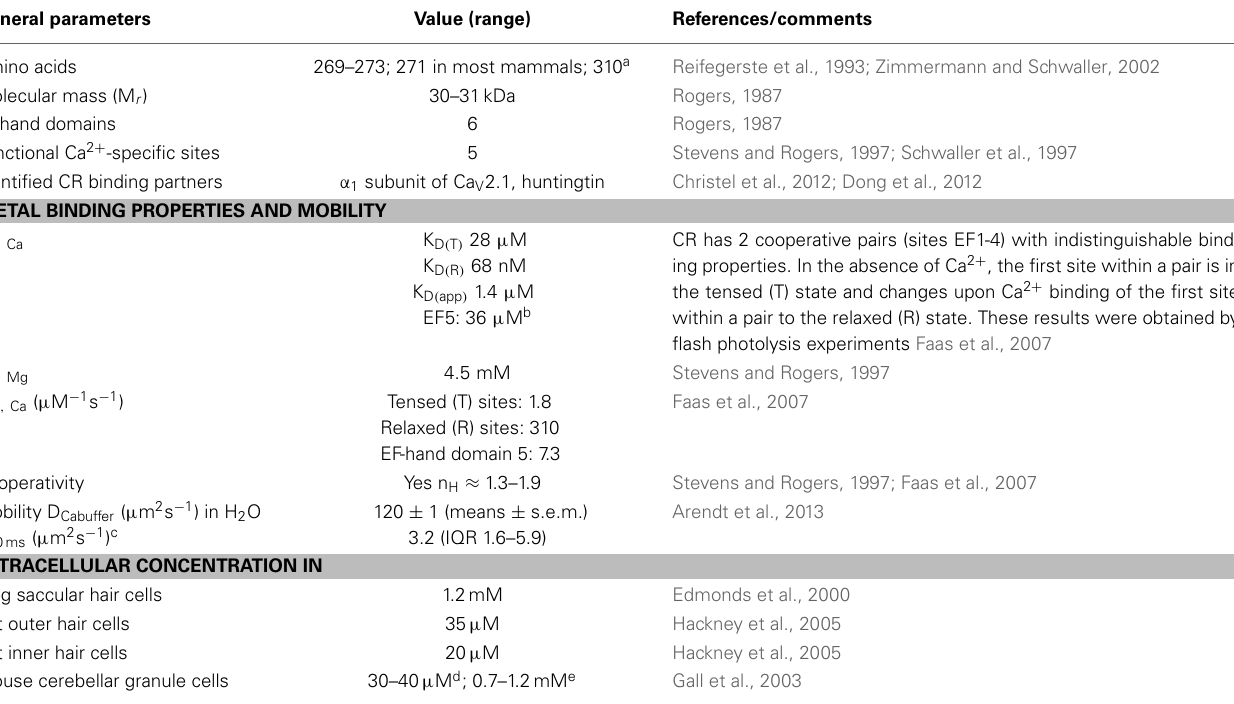
Table 1 | Properties of calretinin (modified from Schwaller, 2009, 2010,